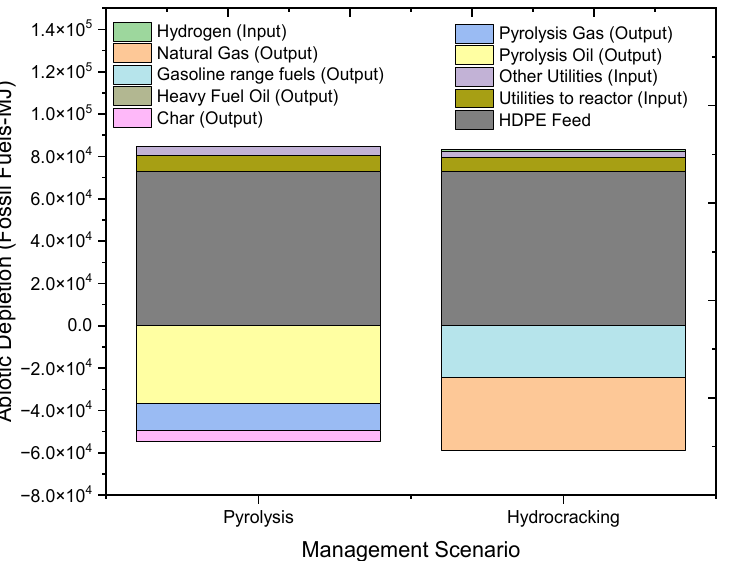
Figure 8. Impact assessment of pyrolysis and hydrocracking for the management of waste HDPE on abiotic depletion of fossil fuels (MJ).